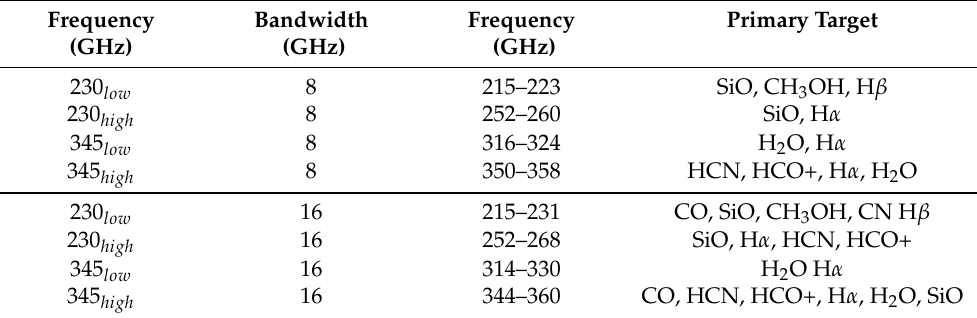
Figure 1. Distribution of spectral lines over the frequency range of 1.3mm and 0.8mm. Each color indicates the type of spectral lines. Frequency coverage of 8GHz and 16GHz observations is marked with two different frequency tunings (low and high). Table 3. Suggested frequency tunings with different bandwidths (8GHz and 16GHz) at each band for spectral line VLBI